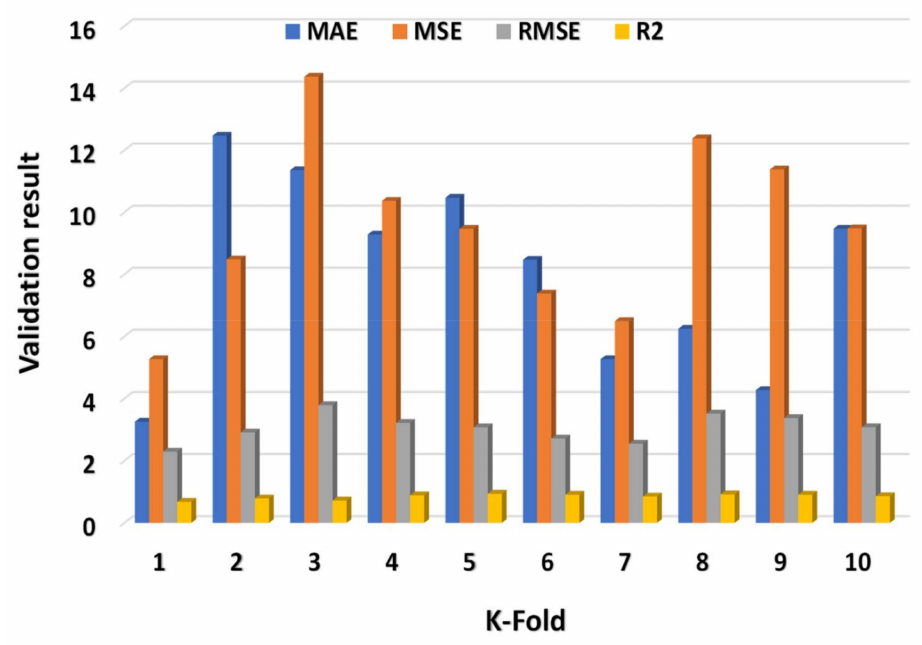
Figure 10. SVM model’s statistical explanation of CV analysis.